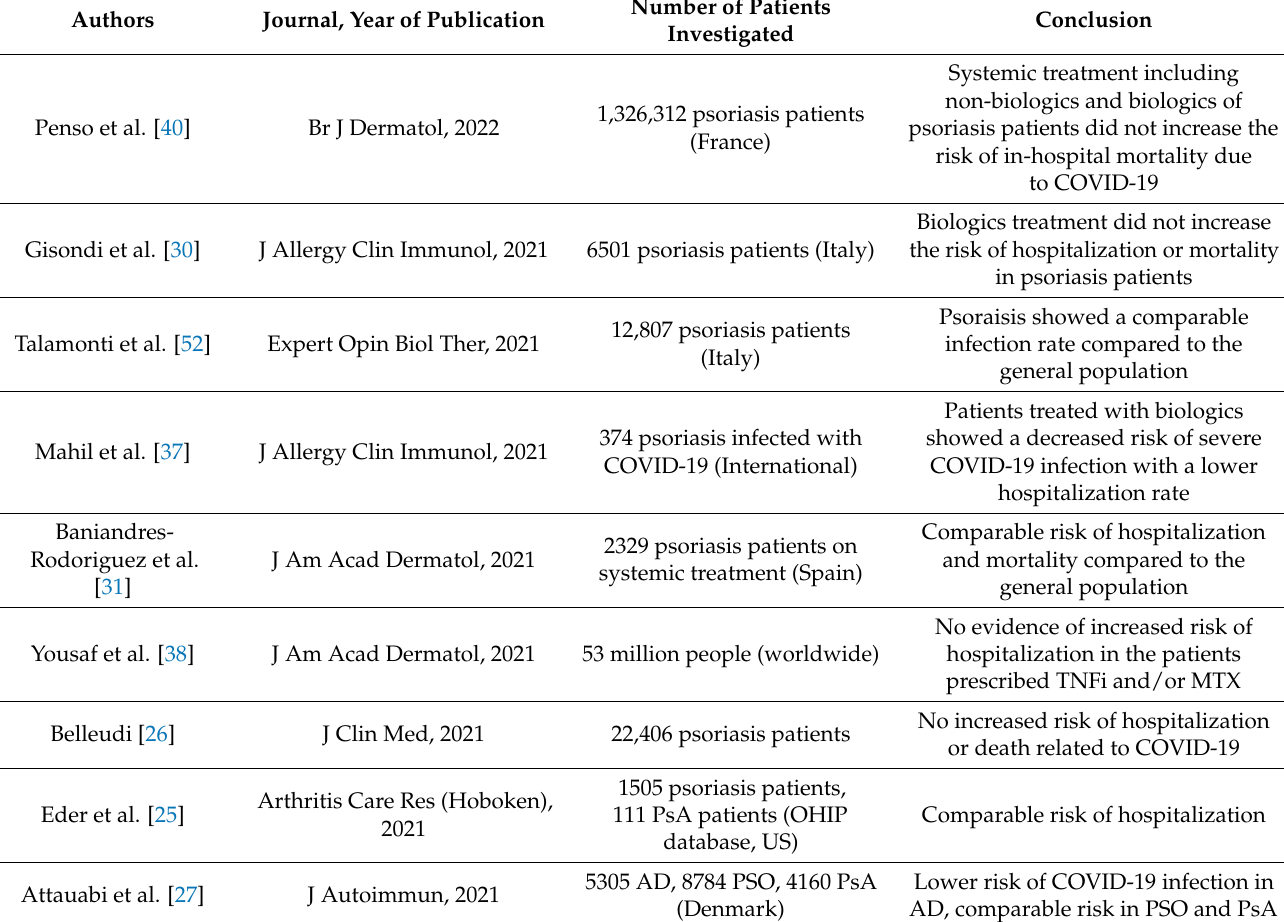
Table 1. Published epidemiological studies on COVID-19 and